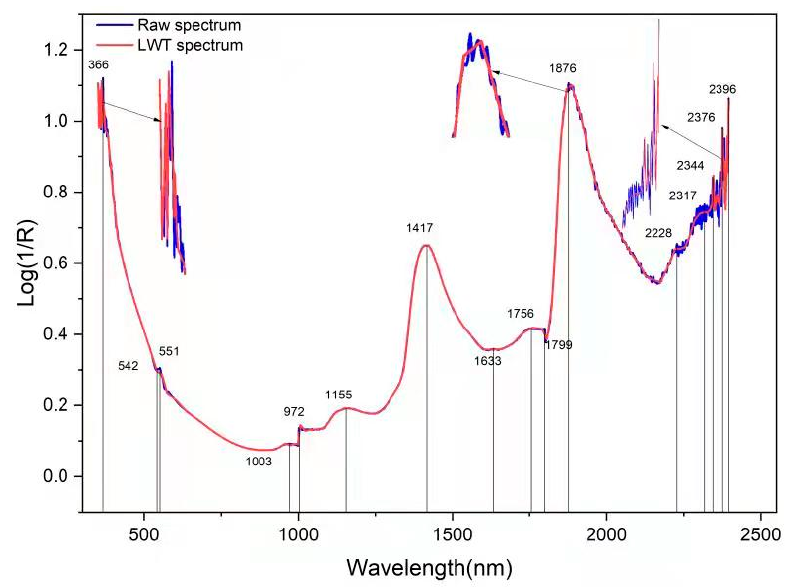
Figure 3. Raw spectrum and LWT spectrum of a random sample.